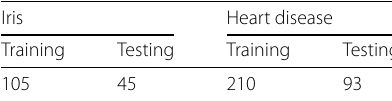
Table 6 Training and testing data of each dataset